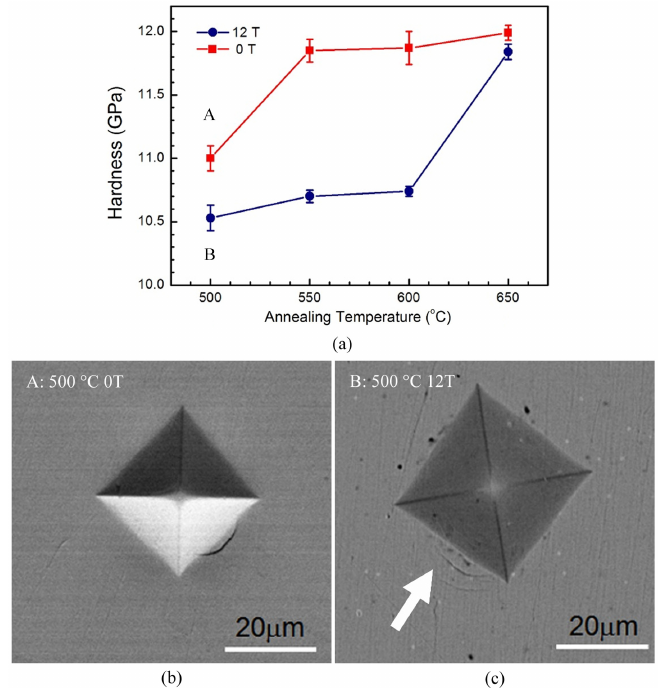
Figure 3. (a) Hardness as a function of annealing temperature in Fe The corresponding indentation images for the rod annealed at (b) 500 °C under 0T and (c) 500 °C under 12T external field.